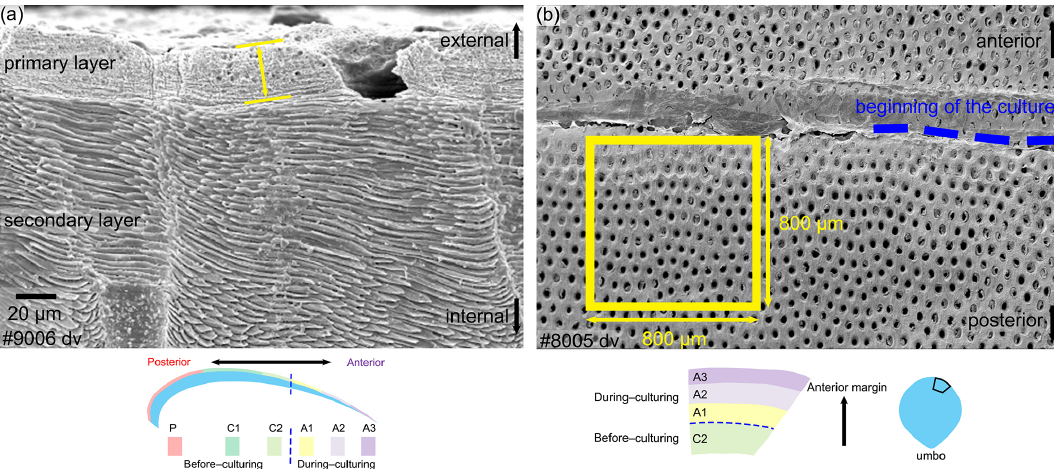
Figure 4. Measurement methods used for the thickness of the primary layer (a) and the density of the endopunctae (b) . Note that for the latter, endopunctae were counted when included for more than their half-diameter inside the square. dv: dorsal valve.